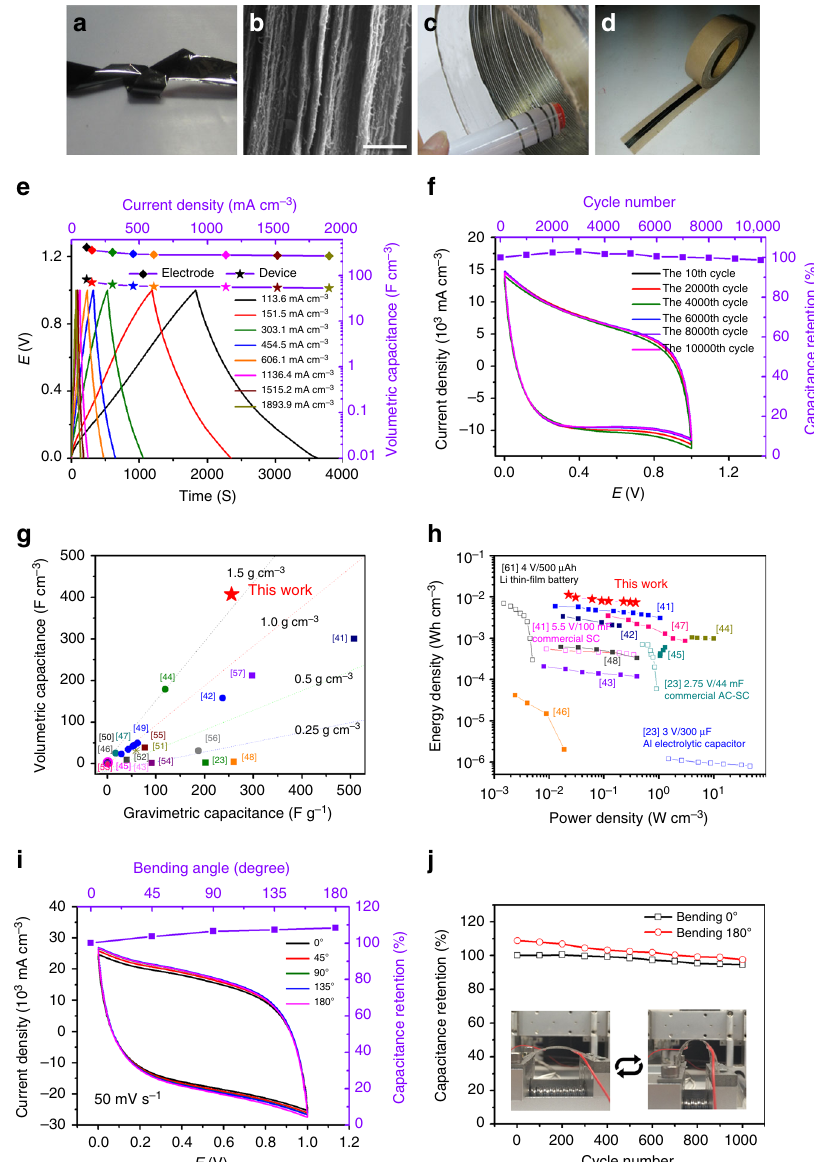
Fig. 4 Structure and electrochemical performances of rGO/SWCNT hybrid- fi lm-based fl exible tape SCs. a A folded rGO/SWCNT hybrid fi lm. b Cross- sectional SEM image of a rGO/SWCNT fi lm. Scale bar: 1 μ m. c Continuous long rGO/SWCNT hybrid ribbon obtained by cutting a fi lm. d Tape SC made by the ribbon in c . e Galvanostatic charge/discharge curves measured between 0 and 1 V at current density from 114 to 1894 mA cm − 3 , and the electrode and device volumetric capacitance as a function of current density. f Cycle life of the tape SC. CV curves after 10, 2000, 4000, 6000, 8000, and 10,000 cycles between 0 and 1 V at 100 mV s – 1 , and the volumetric capacitance retention as a function of cycle number. g Volumetric and gravimetric capacitance comparison of rGO/SWCNT-1 hybrid fi lm and the reported electrode materials. h Volumetric energy and power densities of our tape SC (red stars) compared with the reported all-solid-state SCs with different electrode materials (solid squares) and commercially available state-of-the-art energy storage systems (open squares). i CV curves collected at a scan rate of 50 mV s – 1 and the capacitance as a function of bending angle. j Capacitance retention under both fl at and 180° bent states after 1000 cycles. Inset: a digital photograph showing the fl exibility of the